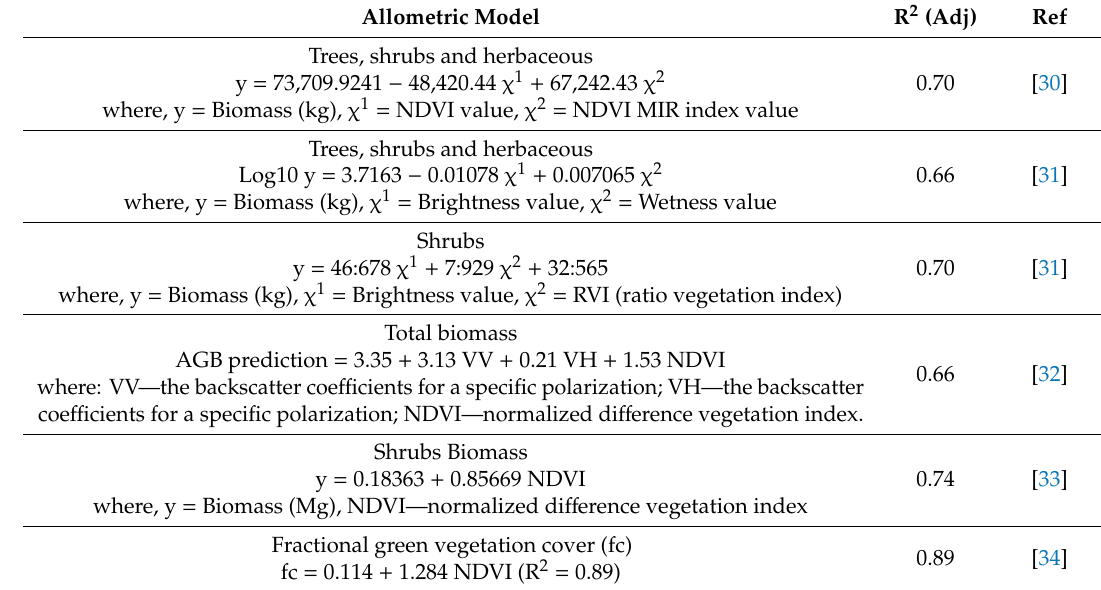
Table 1. Biomass regression models based on vegetation